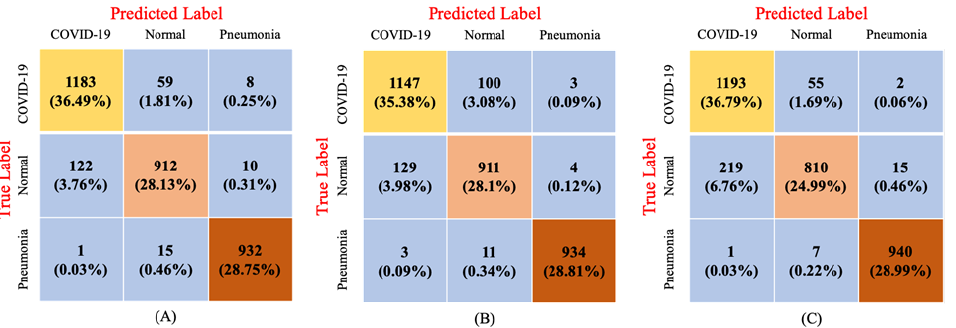
Figure 6. Confusion matrix of the best-performing methods: ( A ) ResNet152V2 with GRU in original image, ( B ) VGG19 with LSTM in normalized image technique and ( C ) DenseNet121 with LSTM in normalized image